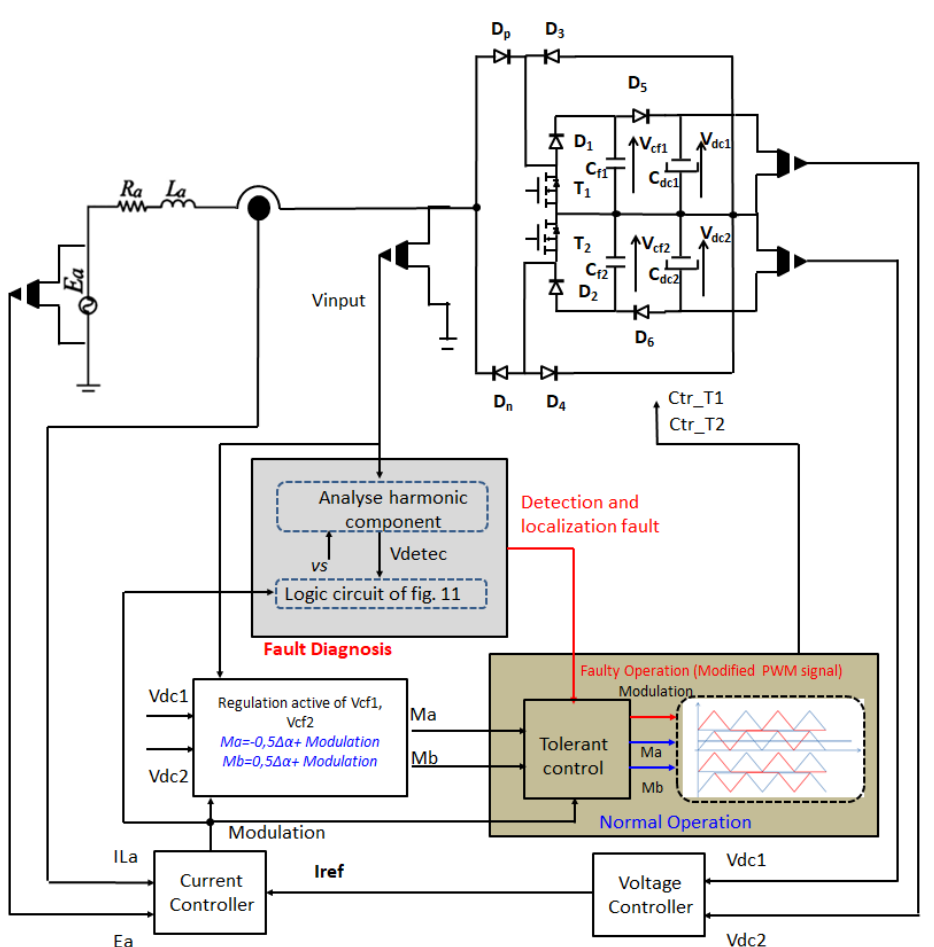
Figure 9. Representation of the functions of the fault detector for a five-level VIENNA Converter.